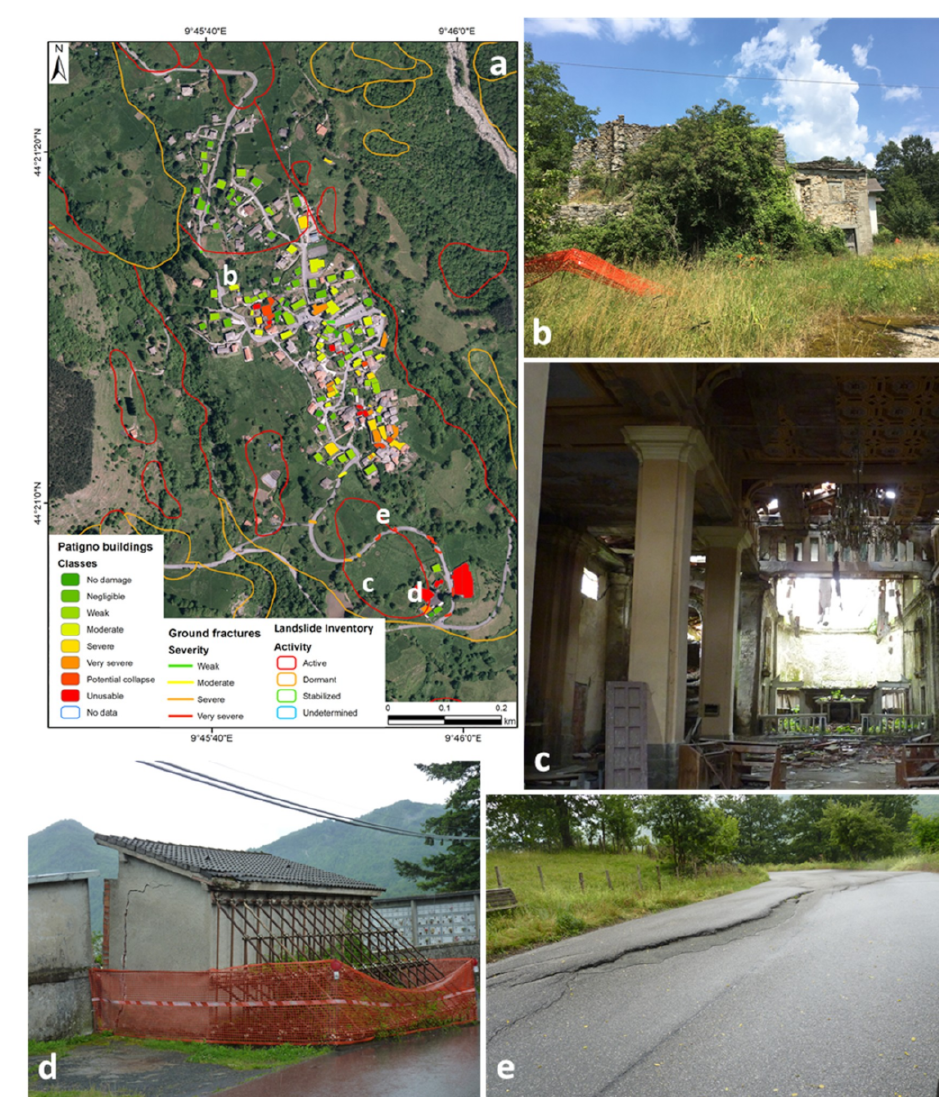
Figure 7. Building damage classification map of Patigno hamlet ( a ). Di ff erent situations can be recognized: a group of buildings abandoned in the center ( b ); collapsed and highly damaged structures, church and cemetery, at the toe ( c , d ); important ground fractures recognizable along a linear infrastructure (i.e., a road) ( e ).